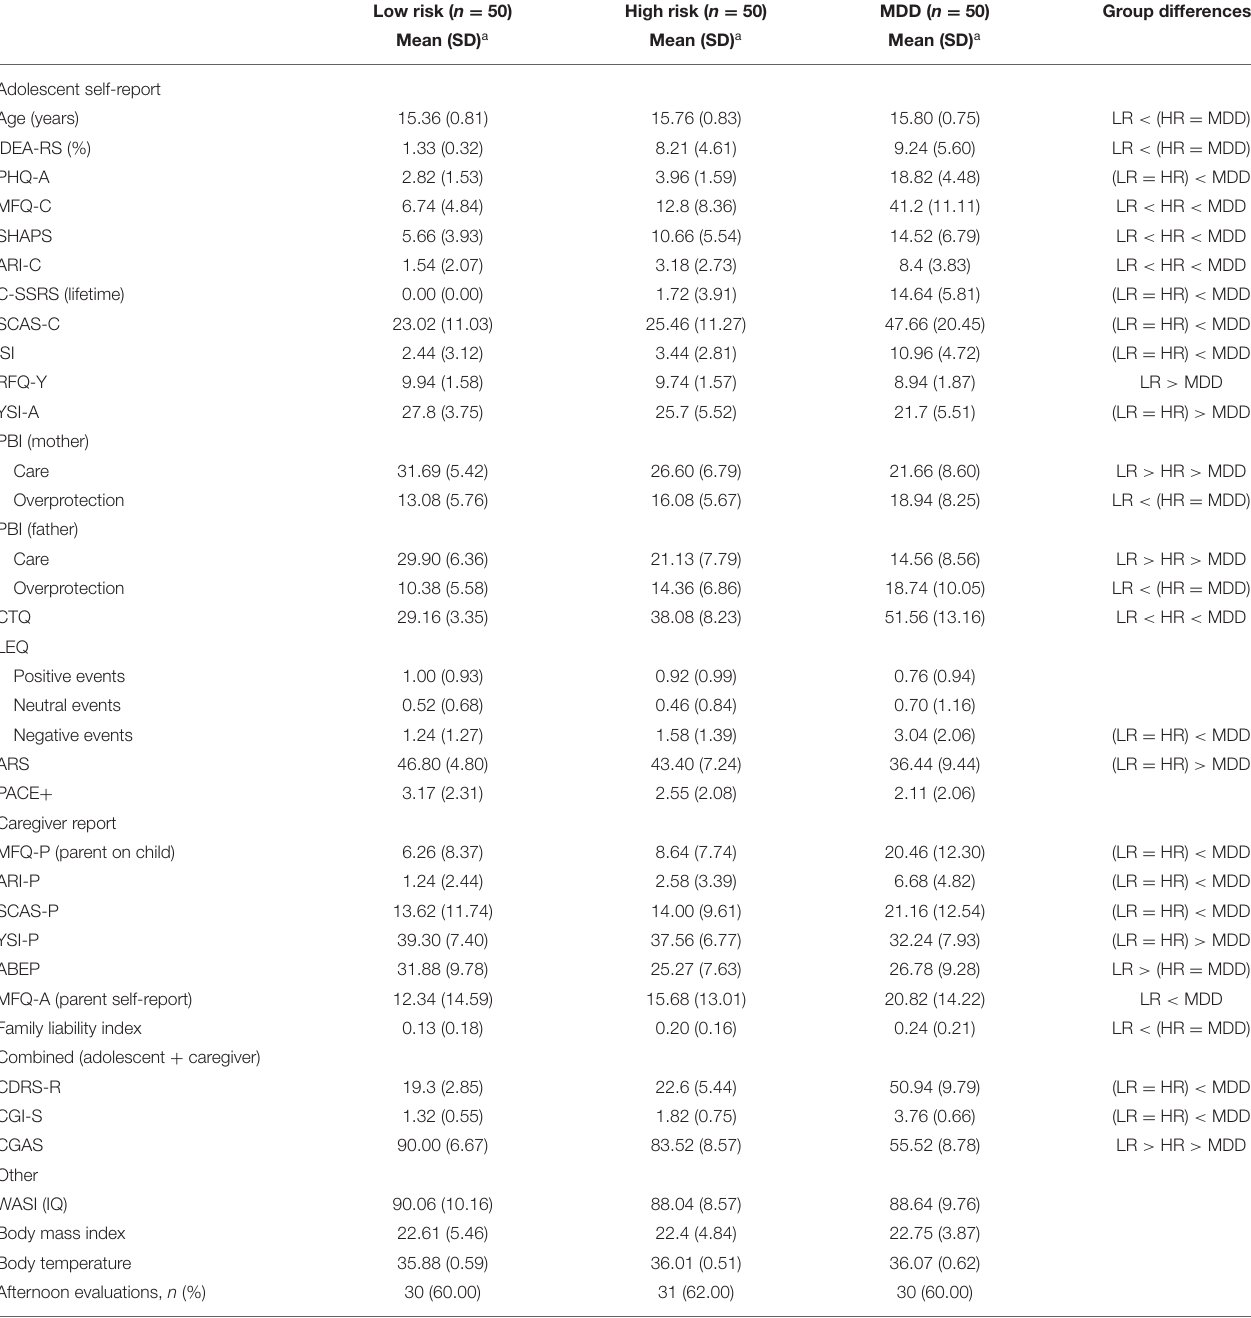
TABLE 2 | Phenotypic characteristics of the IDEA-RiSCo